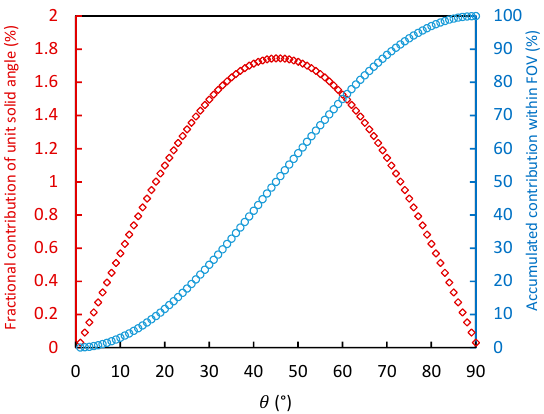
Figure 2. Fractional contribution of the signal coming from each 1° interval of the view zenith angle to the hemispherical irradiance (red diamonds) together with the accumulated contribution of the signal within the FOV (blue circles).